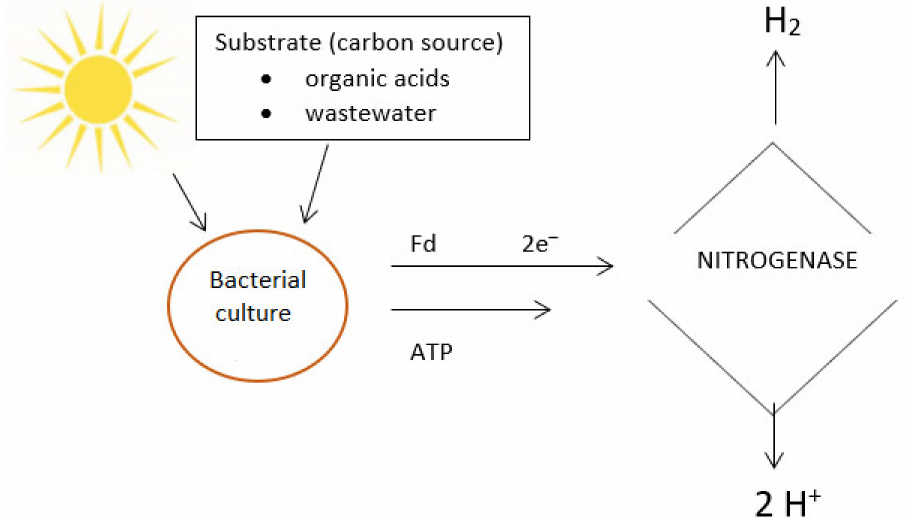
Figure 2. Diagram of photofermentative hydrogen production by